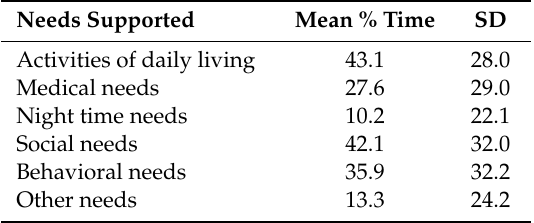
Table 1. Percent time personal support workers (PSWs) reported spending supporting various consumer